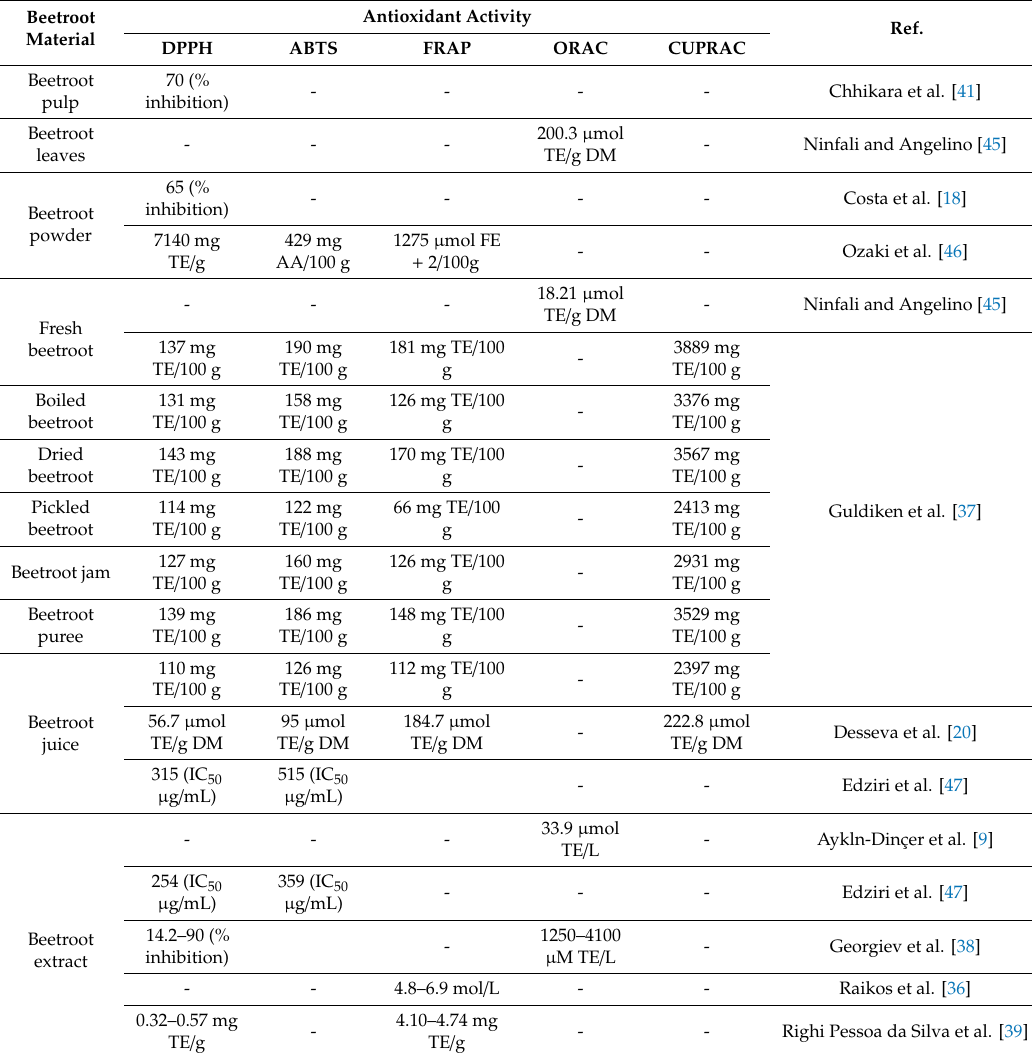
Table 2. Antioxidant activity in di ff erent beetroot